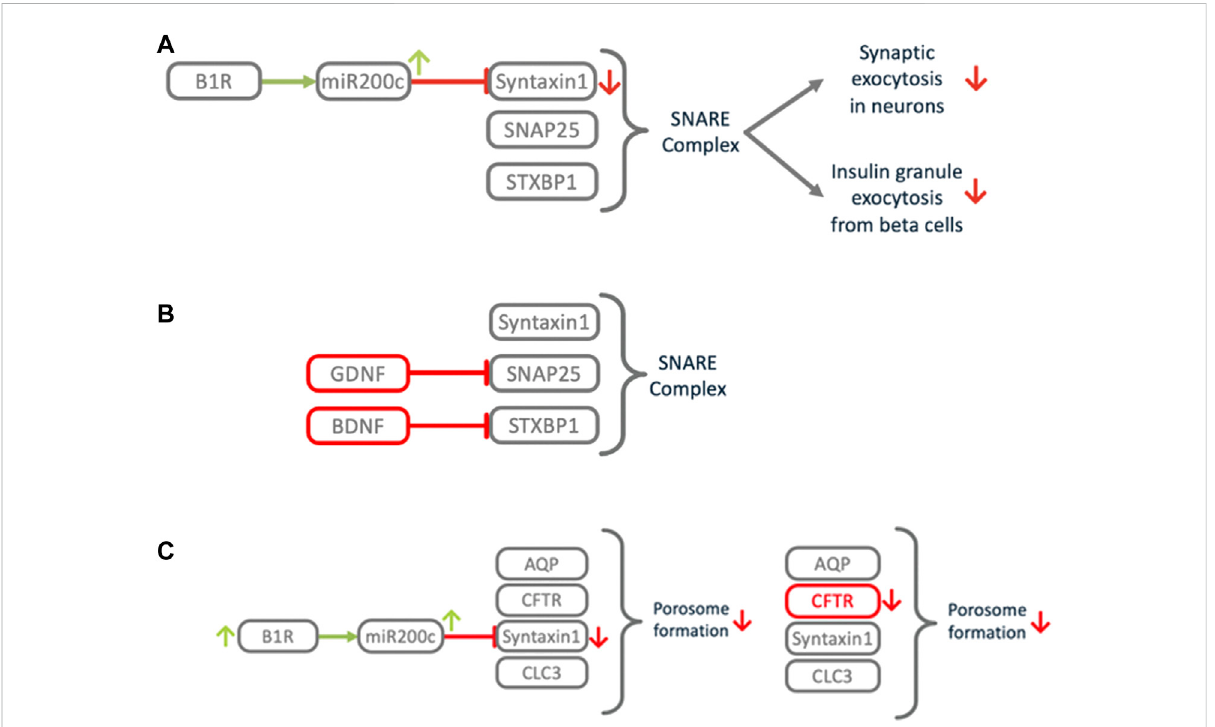
FIGURE 11 Impact of B1R induced miR200c on exocytosis and related processes. (A) Downregulation of Syntaxin1 impairs the SNARE complex, a central element of the exocytosis machinery. This impacts signal transduction between neurons, which might cause COVID-19 associated anosmia, ageusia, cognitive impairment or silent hypoxia. (B) Congenital central hypoventilation syndrome (CCHS) causes the same symptoms as COVID- associatedsilenthypoxemia.InCCHSdefectsingrowthfactorsGDNForBDNFcausedownmodulationofSNAP25orSTXBP1,leadingtoSNARE dysfunction in the oxygen sensing carotid bodies. (C) COVID-19 associated thick mucus resembles the cystic fi brosis (CF) phenotype. In CF, mutations inCFTRcauseporosome dysfunction,which impairstheSNAREdependenttransientfusionofsecretoryvesiclesattheporosome. Excess activation of B1R may induce local downregulation of Syntaxin1, which is also involved in this process, thus mimicking the CF